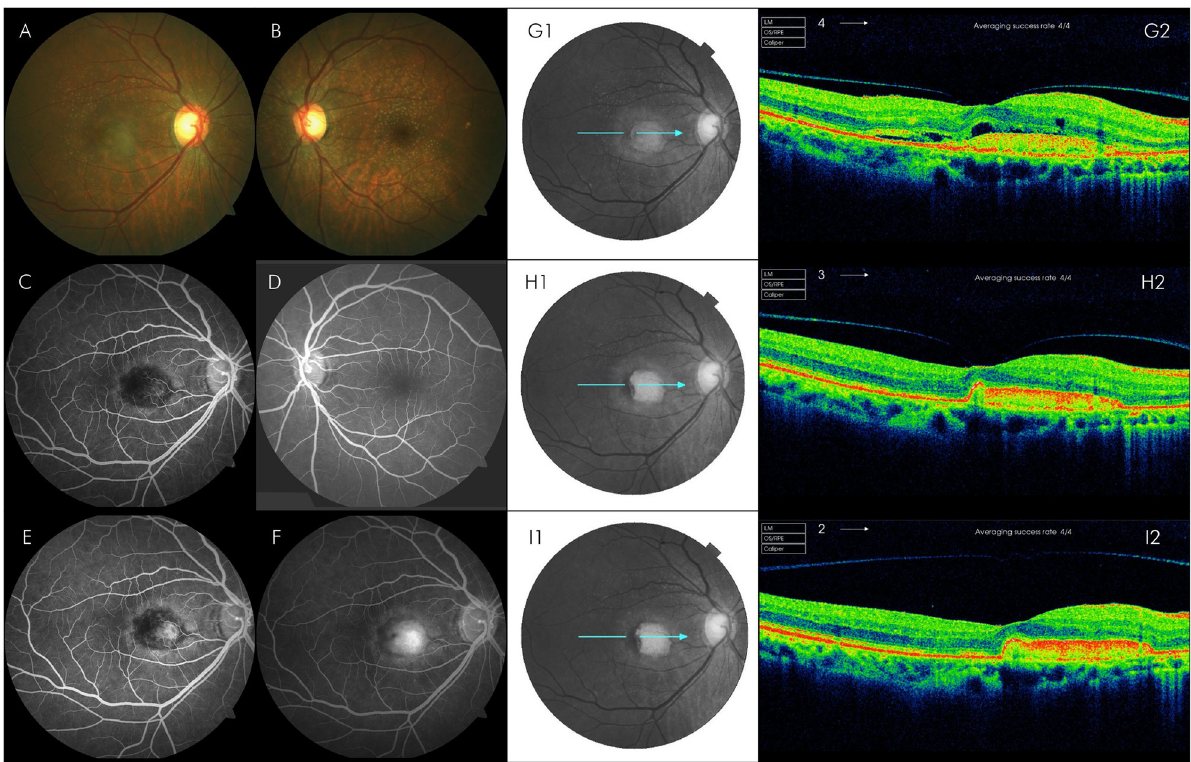
Fig 3. Fundus photograph (CFP), fluorescein angiogram (FFA) and spectral domain optical coherence tomography (SD-OCT) of a 56-year female presenting with metamorphosia in the right eye of 2 months’ duration. CFP (A and B) shows drusen and reticular pseudodrusen (RPD) in both eyes with subfoveal CNV in the right eye confirmed with FFA (C-F). SD-OCT showed vitreomacular adhesion (VMA), intraretinal (IRF) and subretinal fluid (IRF) and retinal pigment epithelial detachment (PED) at baseline(G), with resolution of IRF and SRF at 4 (H) and 12 (weeks) and separation of the VMA at 12 weeks (I). Visual acuity at baseline of 0.4 LogMAR improved to 0.24 LogMAR and 0.2 LogMAR at 4 and 12 weeks, respectively.